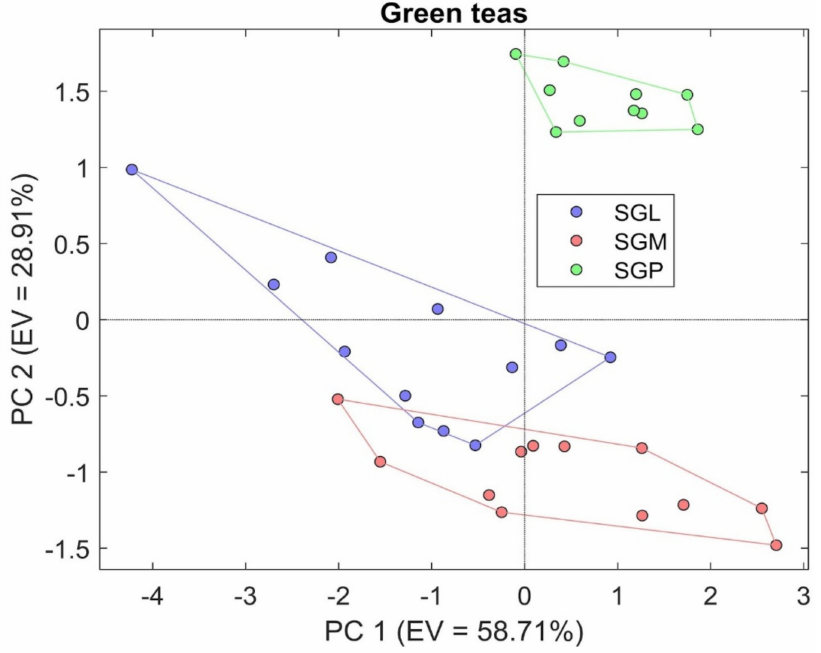
Figure 3. PCA analysis representing the results obtained from the comparison between green tea.